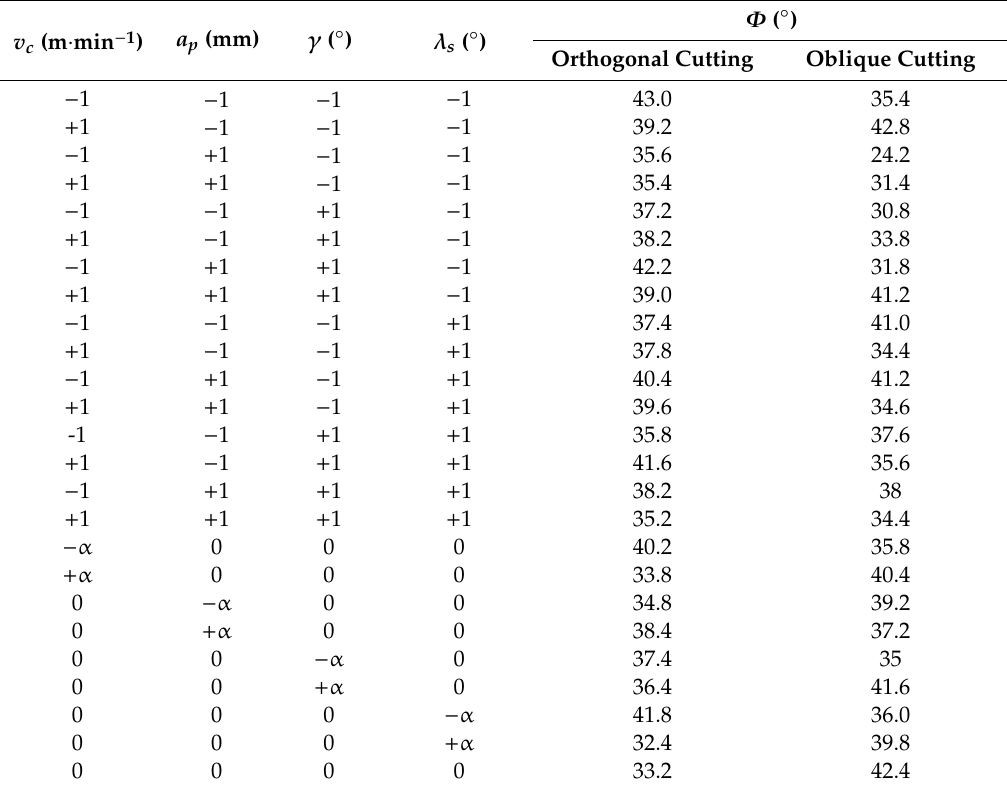
Table 7. The measured shear angle values Φ for both orthogonal and oblique cutting of EN 16MnCr5